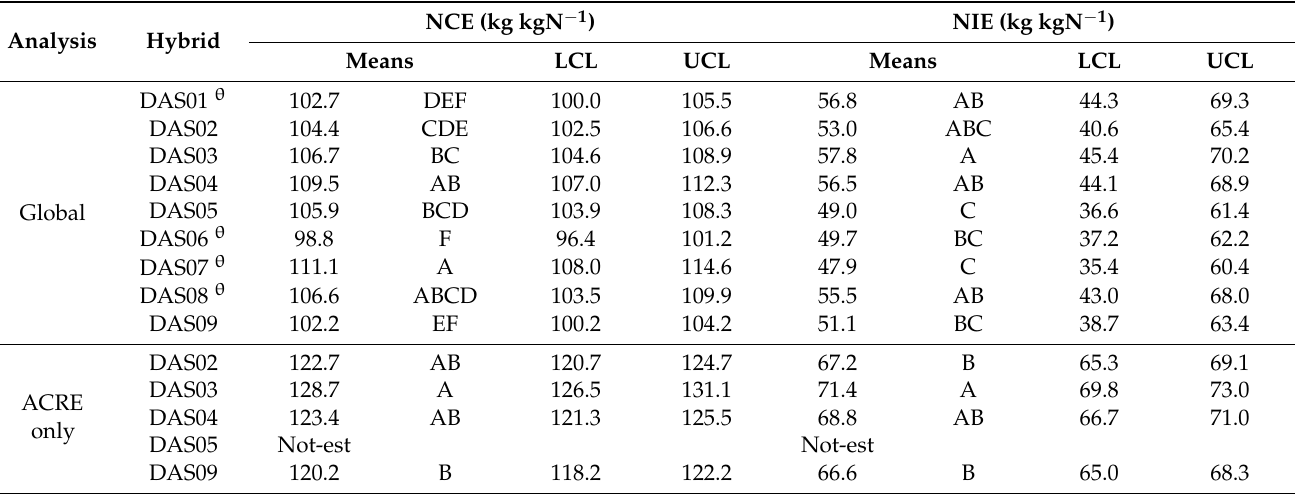
Table 6. NCE and NIE least square mean values from ground reference global models across two θ or three site years or at ACRE-only. Hybrid means with different letters are significantly